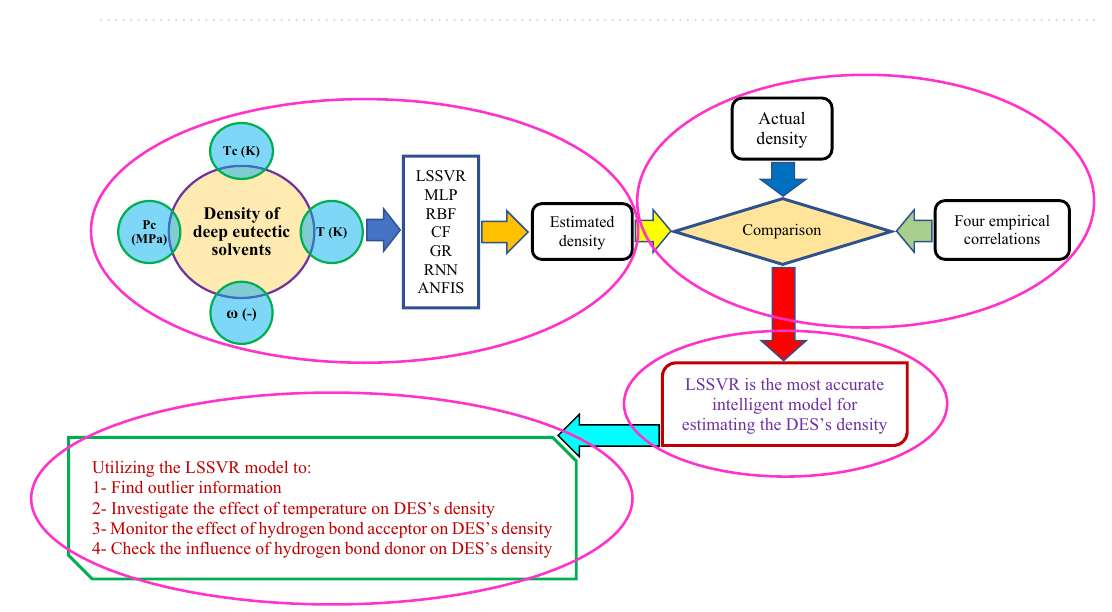
Figure 10. A simple flowchart for explaining the stages followed in the present